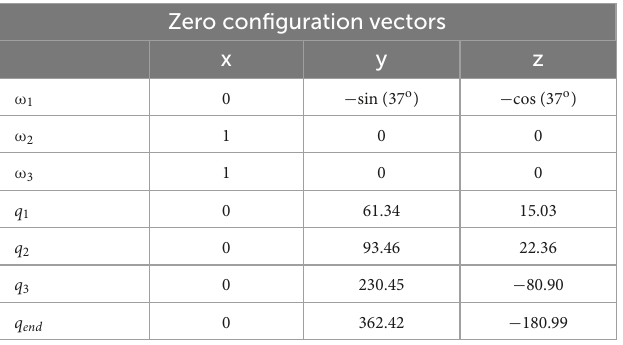
TABLE 1 Zero configuration of model parameters in vector form.